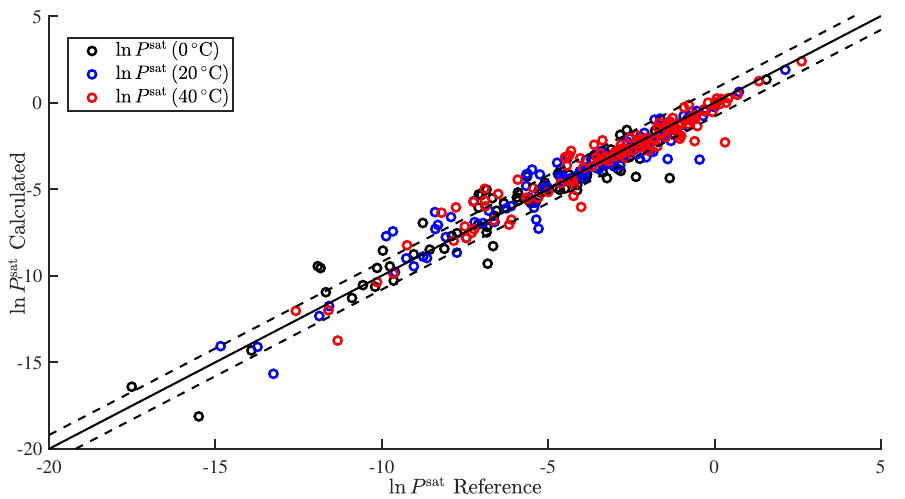
Figure 1. Parity plot of ln P sat calculated using Equation (17) at 0, 20, and 40 ◦ C, as indicated, versus the reference values. P sat is in units of bar. The solid line corresponds to the y = x line, and the dashed lines correspond to plus or minus the root-mean-squared error (RMS) at 20 ◦ C and are drawn as a